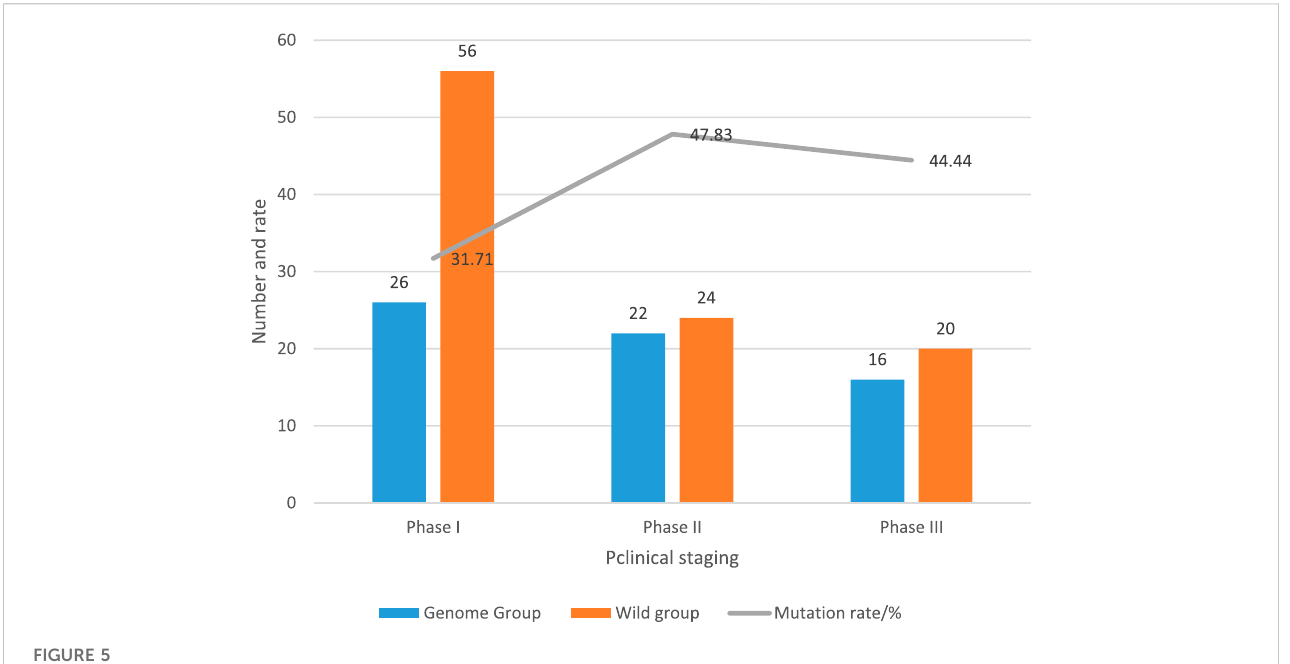
FIGURE 5 The relationship between EGFR gene mutations and clinical stages of